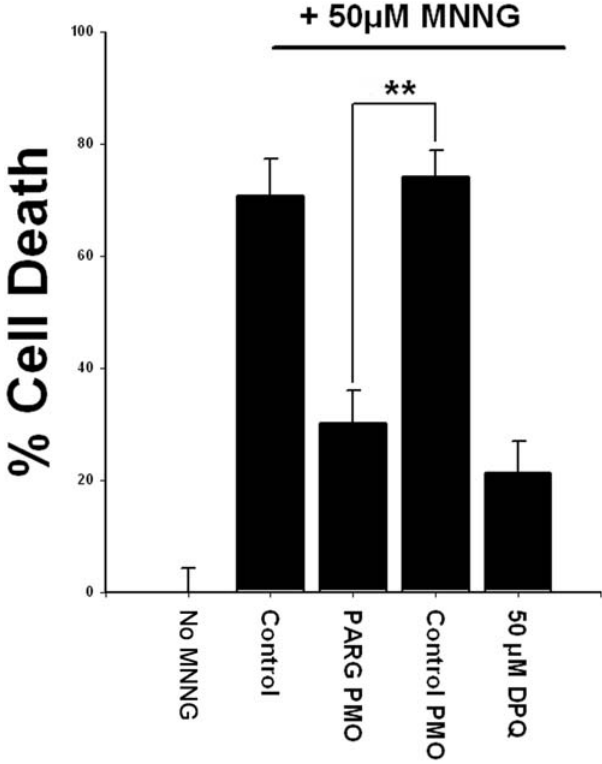
Figure 4. PARP-1 mediated cell death is reduced by PARG antisense PMO. Cell survival was assessed 24 hours after 60-minute incubations with 50 m M MNNG. Cell death was comparably reduced by co-incubation with the PARP inhibitor, DPQ. Data shown are representative of 5 experiments, each with n=3. **p , 0.01 vs. 50 m M MNNG